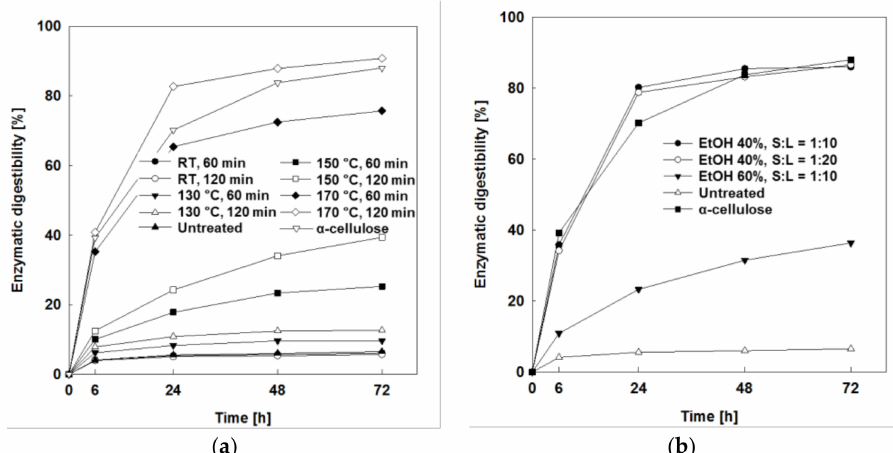
Figure 3. Enzymatic digestibility profiles of treated and untreated Miscanthus × giganteous at: ( a ) 40% ethanol concentration and L/S = 10 and ( b ) 170 ◦ C for 90 min. RT (room temperature); EtOH (ethanol); L/S (liquid/solid); enzymatic hydrolysis conditions: 15 FPU of Cellic ® CTec2/g-glucan, pH 4.8, 50 ◦ C, and 150 rpm.